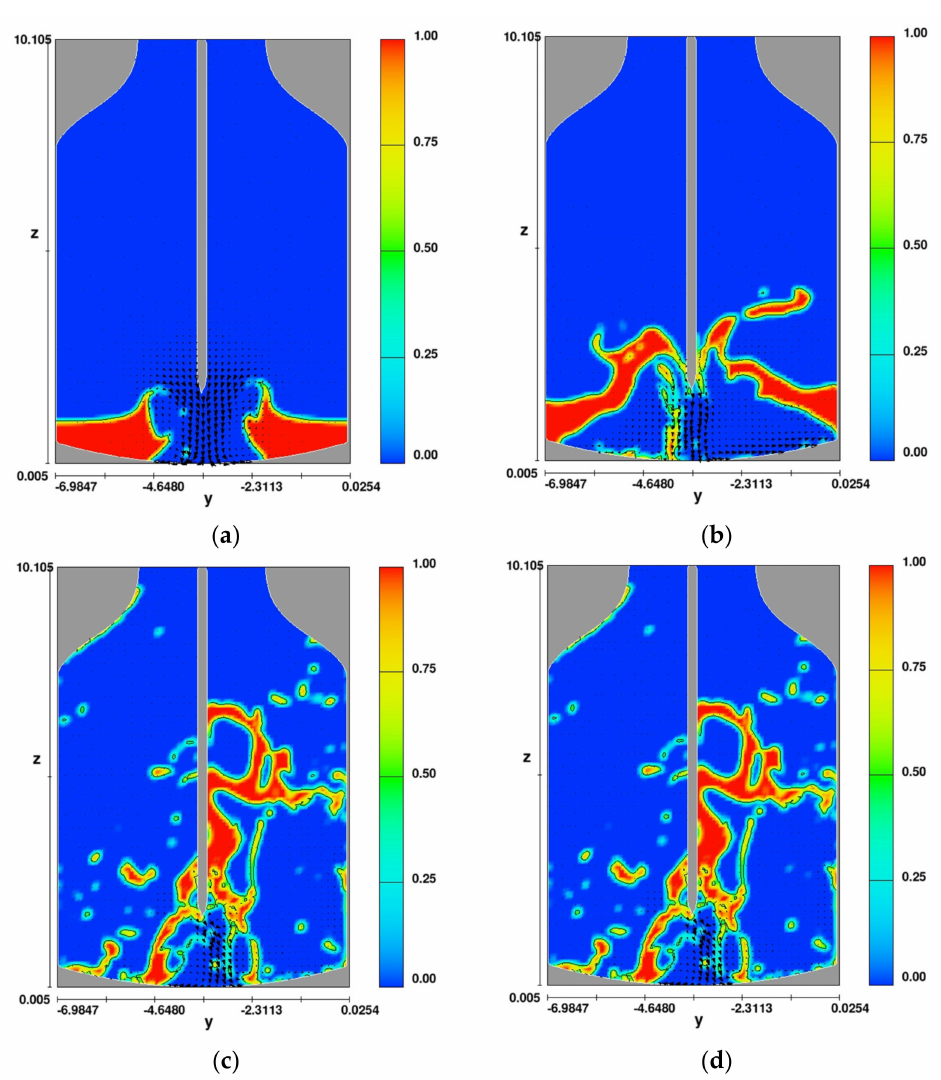
Figure 11. Distribution of phases for variant 1 for time ( a ) 0.1 s, ( b ) 0.45 s, ( c ) 0.1 s, and ( d ) 2.35